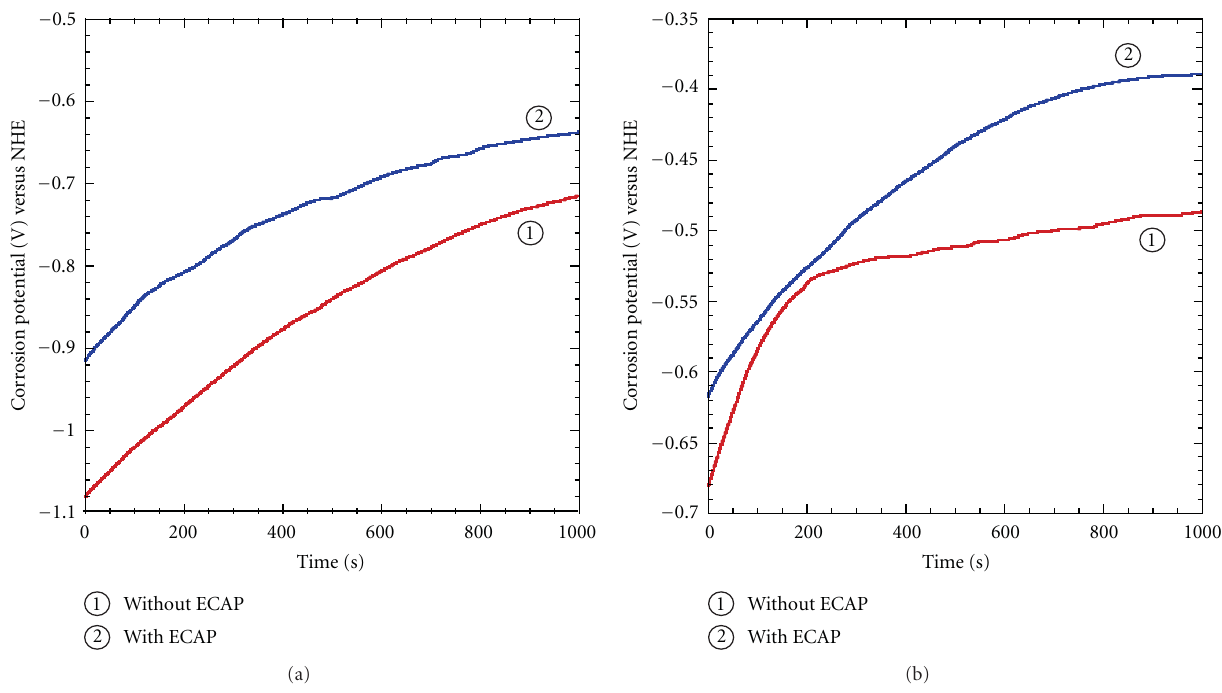
Figure 6: Time-dependence of corrosion potential of pure Al (a) and Al (AA1100) (b) in a solution containing 0.1 mol · dm − 3 of Na 2 SO 4 and 300 ppm of Cl − at 25 ◦